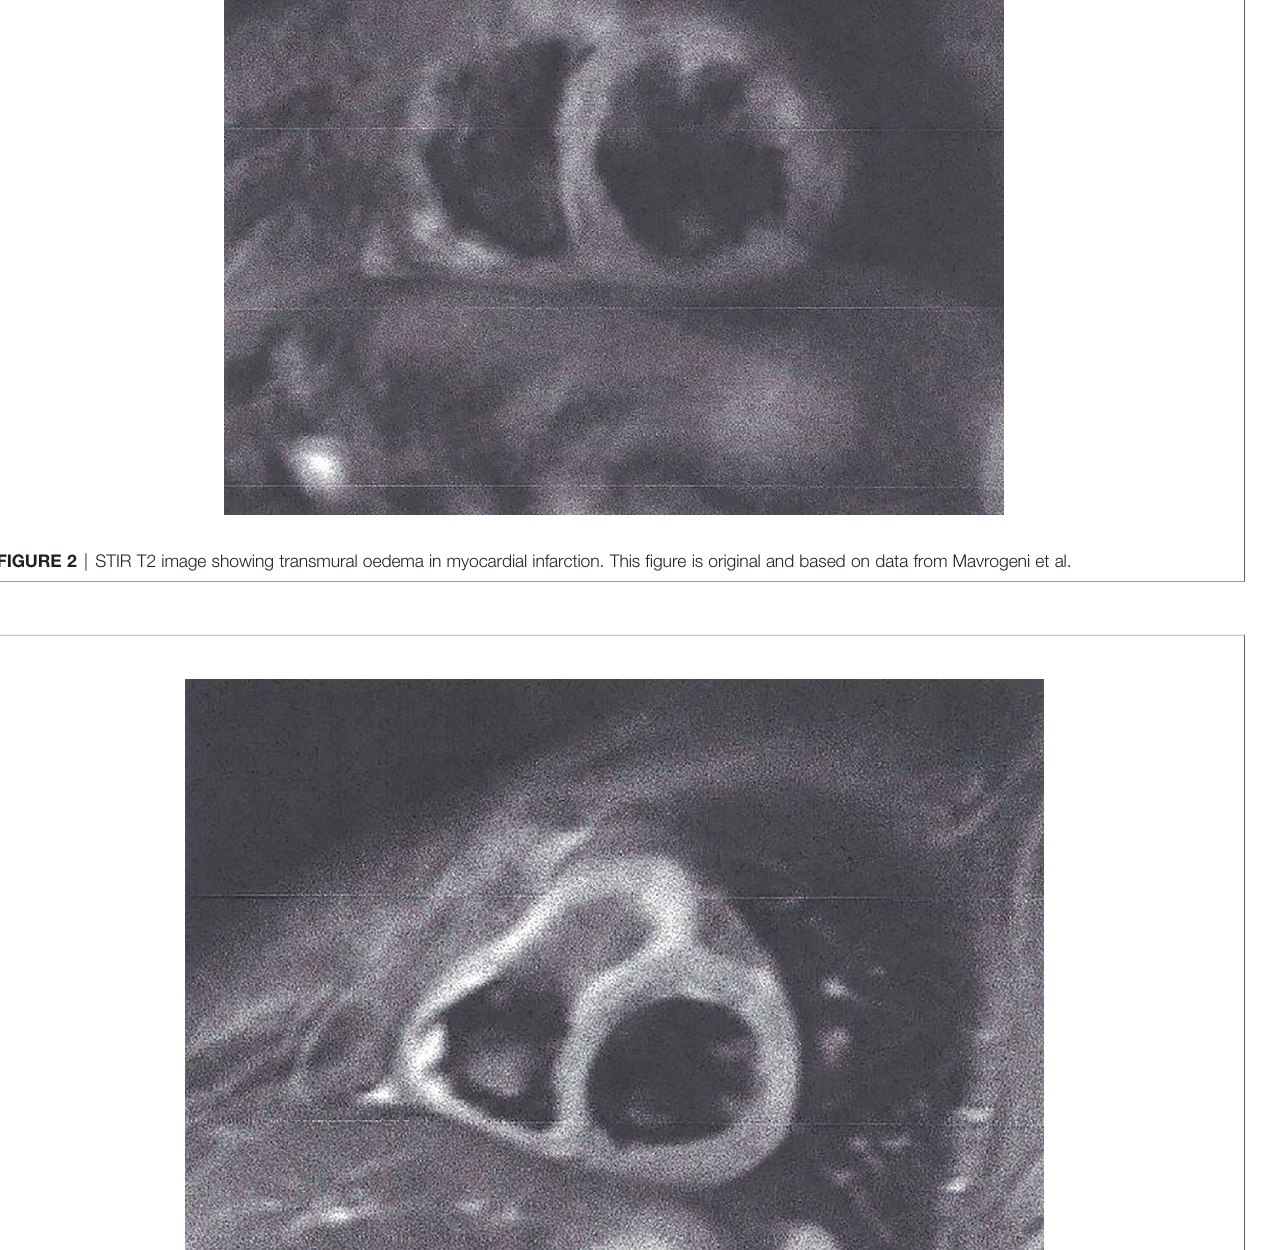
Frontiers in Endocrinology |